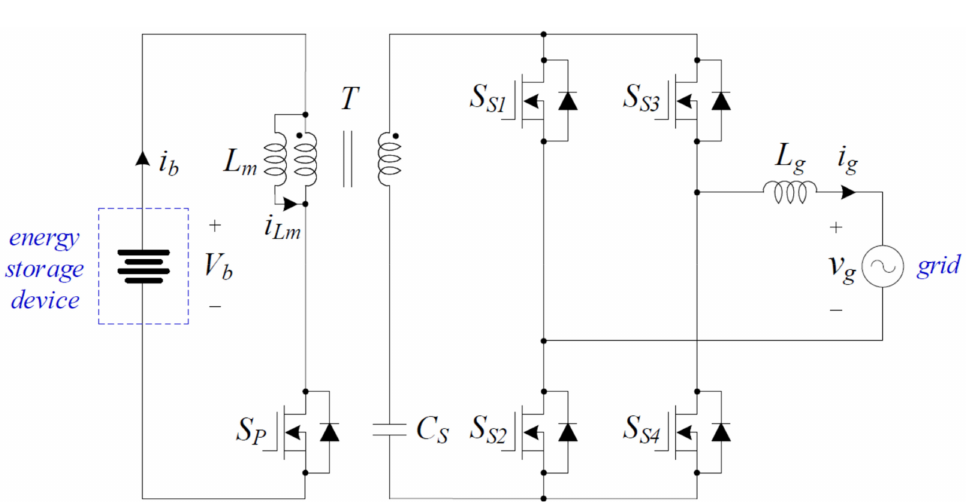
Figure 1. Circuit diagram of the grid-tied zeta inverter for energy storage